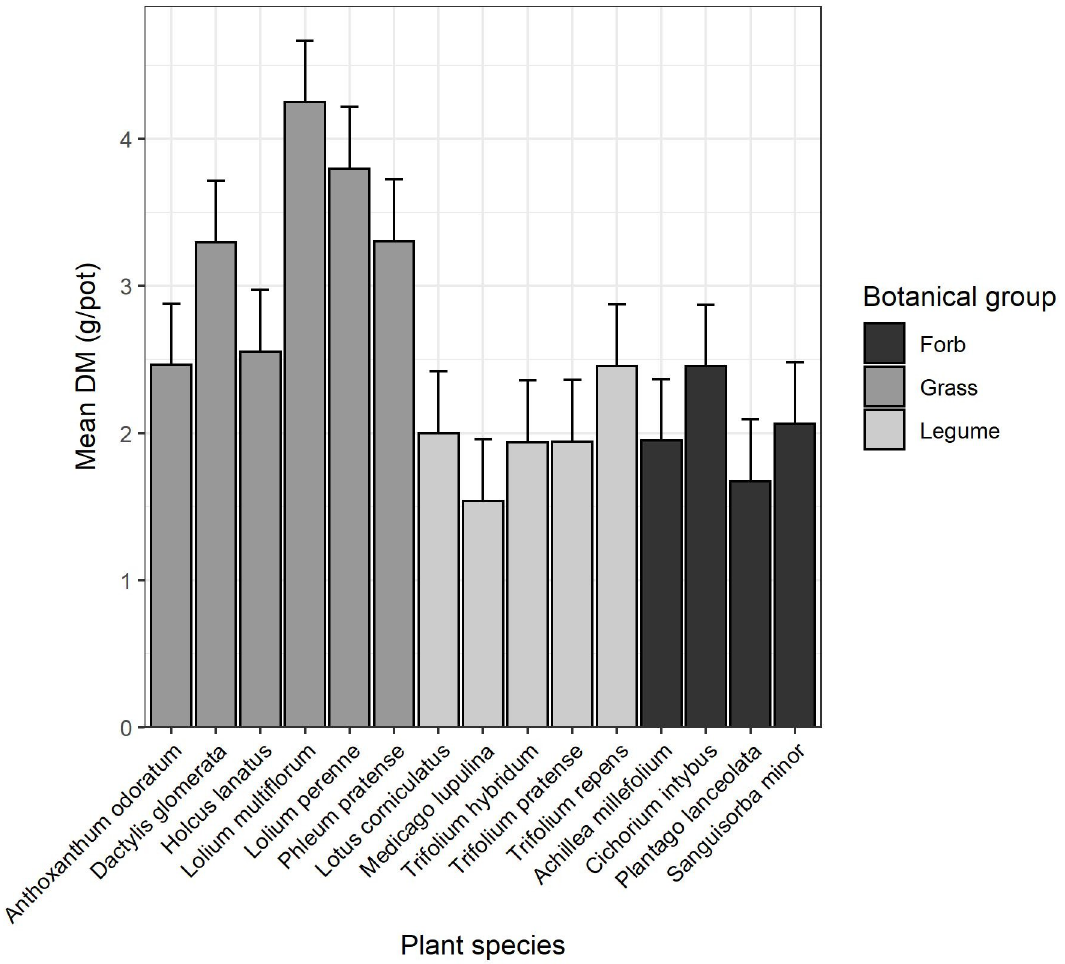
Fig 2. Mean dry matter (DM) yield of species across all of the soil types. Errors bars indicate one standard error. The average least significant difference (LSD) across treatments was 0.491.